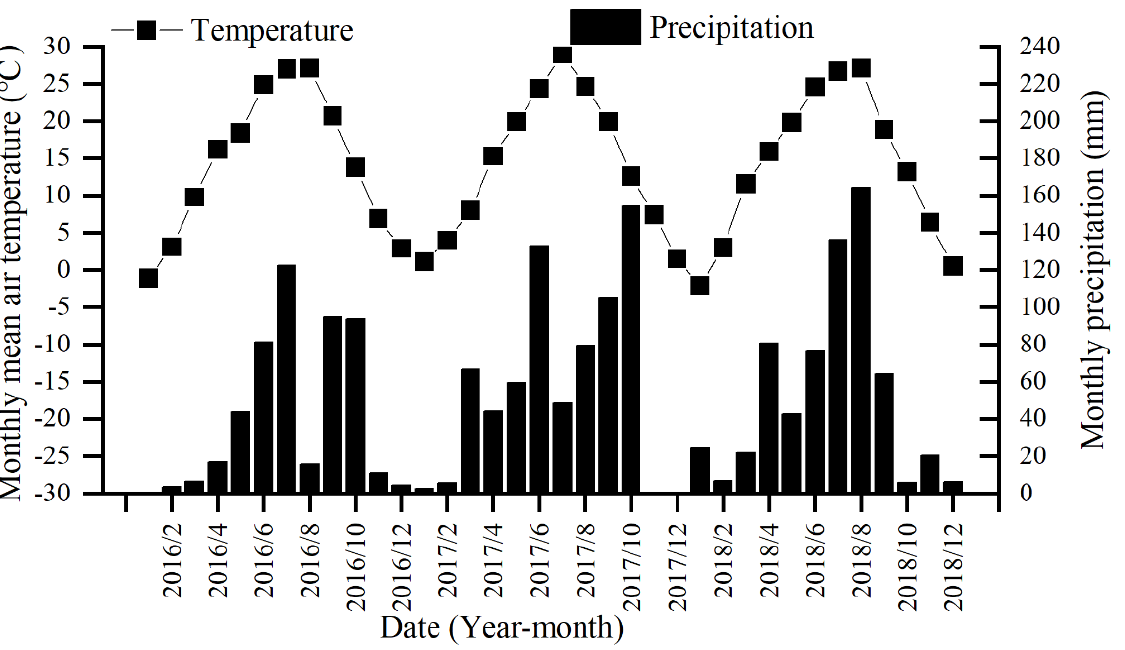
Figure 1. Variation of monthly air temperature and monthly precipitation in the research area during the crop growing seasons from January 2016 to June 2018.